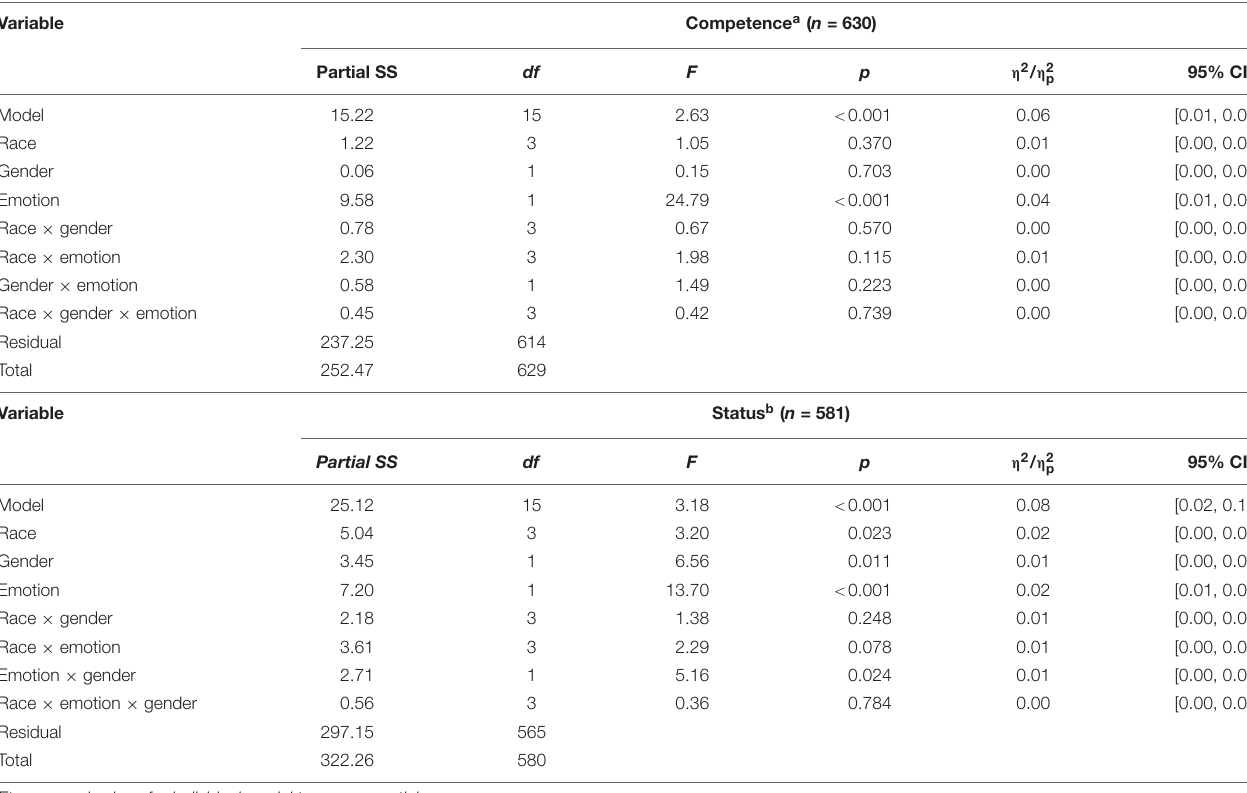
TABLE 3 | Three-way ANOVA models for competence and standardized status.